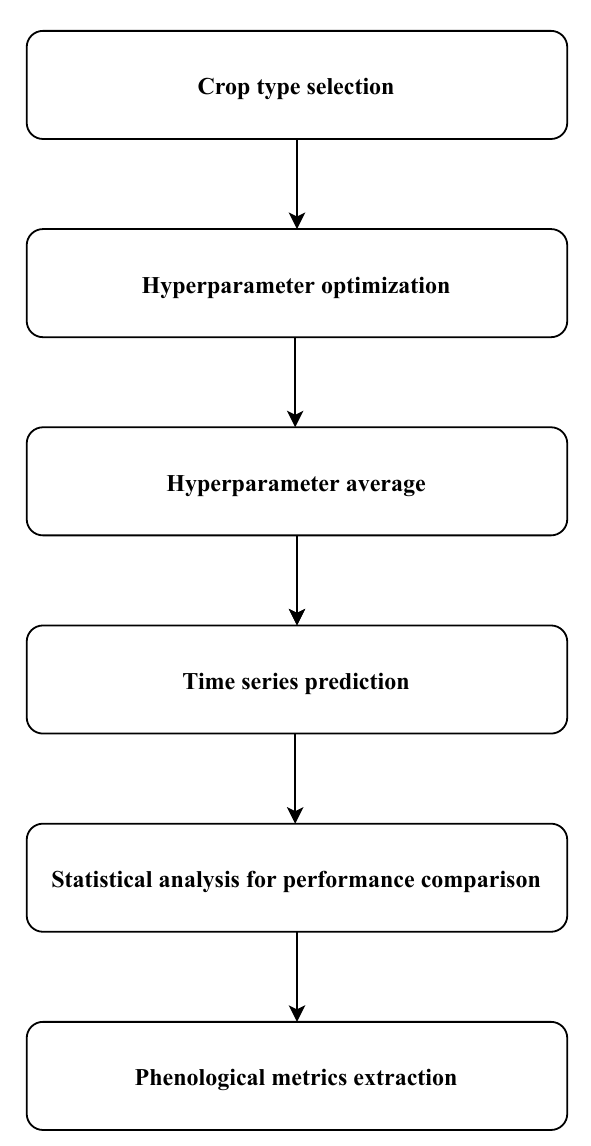
Figure 5. Figure presents an algorithm for image processing, which mitigates the computation burden connected with per-pixel computation for GPR hyperparameters. First, the 100 random parcels larger than 50 pixels are selected for each crop type found in the dataset. Then hyperparameters are optimally determined by assessing individually each pixel across time series. The third step is simply the calculation of the average of trained hyperparameters. Then time series were computed for different GPR model parameterizations using hyperparameters from steps 2 and 3. Finally, performance was evaluated in terms of original vs. reconstructed LAI time series and the results were analyzed in terms of how different parameters affected the estimation of phenological indicators